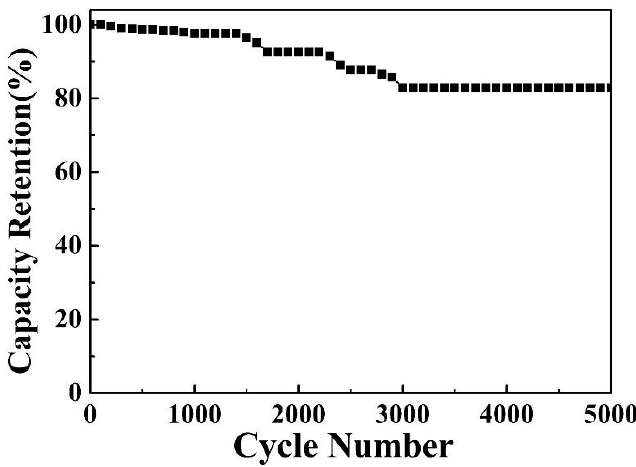
Figure 9. Cyclic stability of the Cu(OH) 2 /NCS electrode.